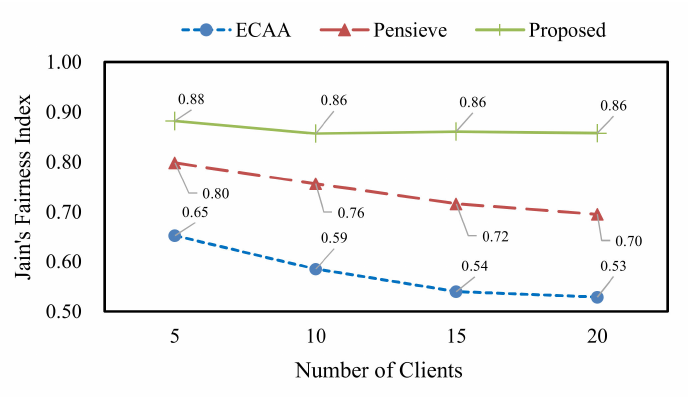
Figure 9. QoE fairness according to the number of